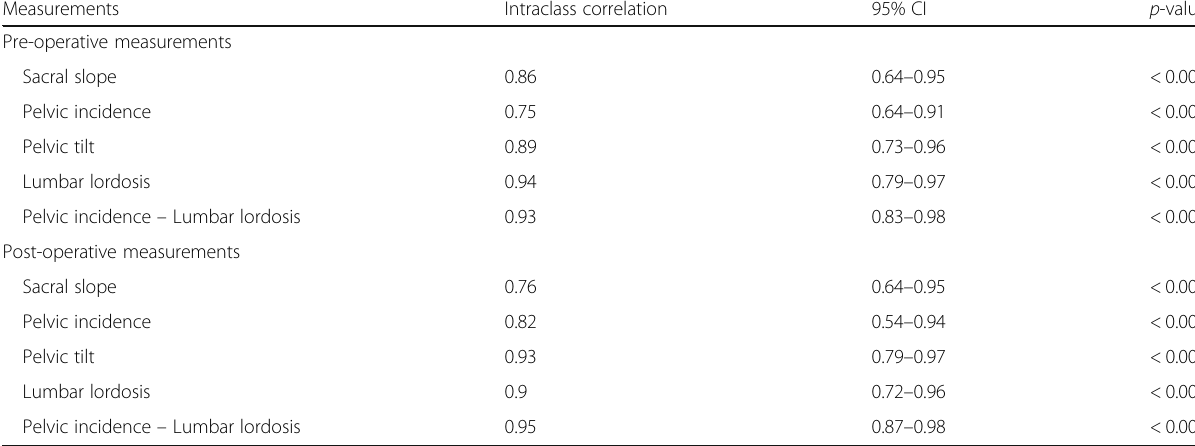
Table 2 Inter-observer analysis of radiographic measurements. Intraclass correlation coefficient with good (> 0.75) or excellent (> 0.90) reproducibility. CI = Confidence Interval